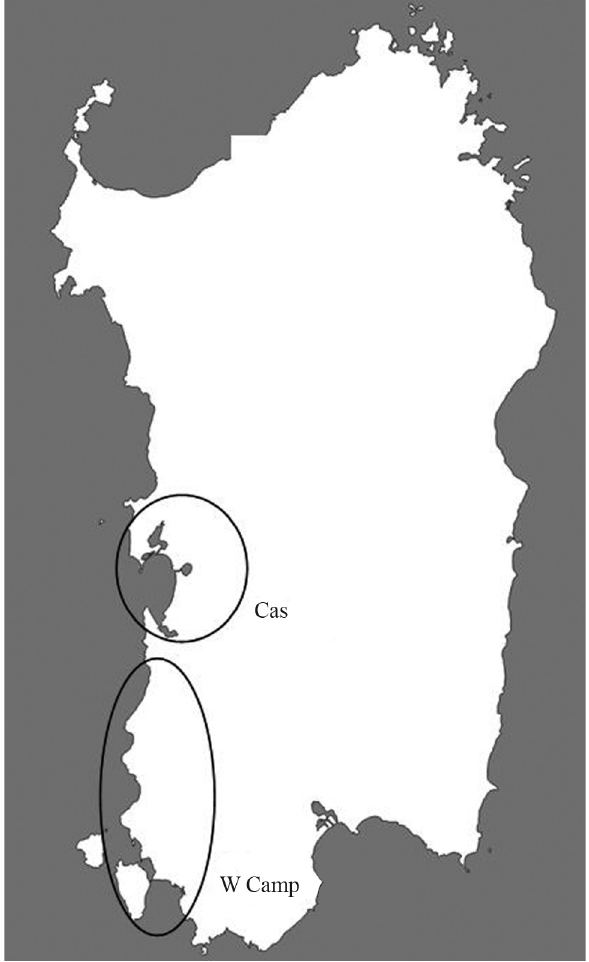
Figure 1 - Map showing the distribution of the two areas analysed in southwest Sardinia. Cas: Cabras. W Camp: western